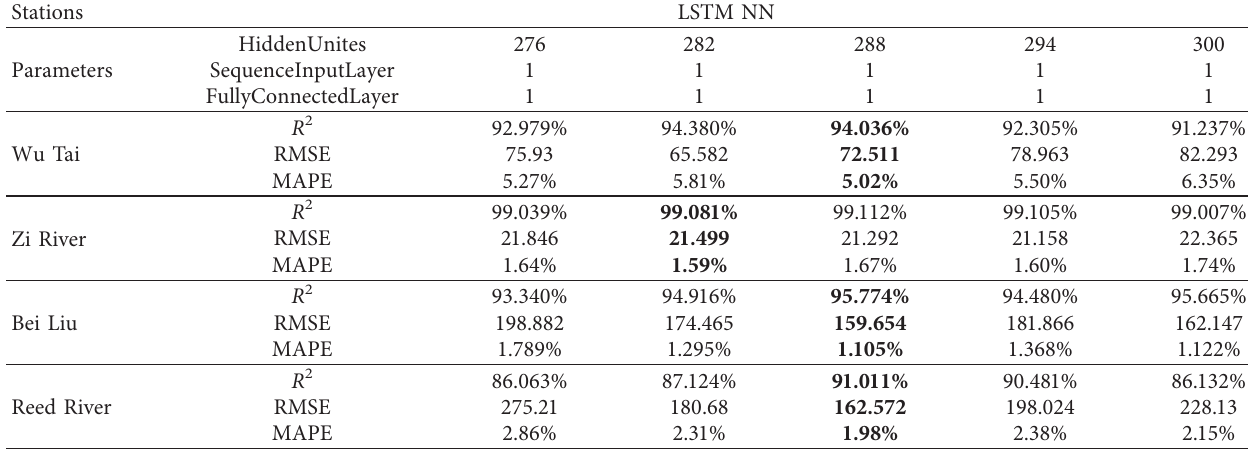
Table 4: Traffic flow prediction accuracy evaluation of LSTM NN.